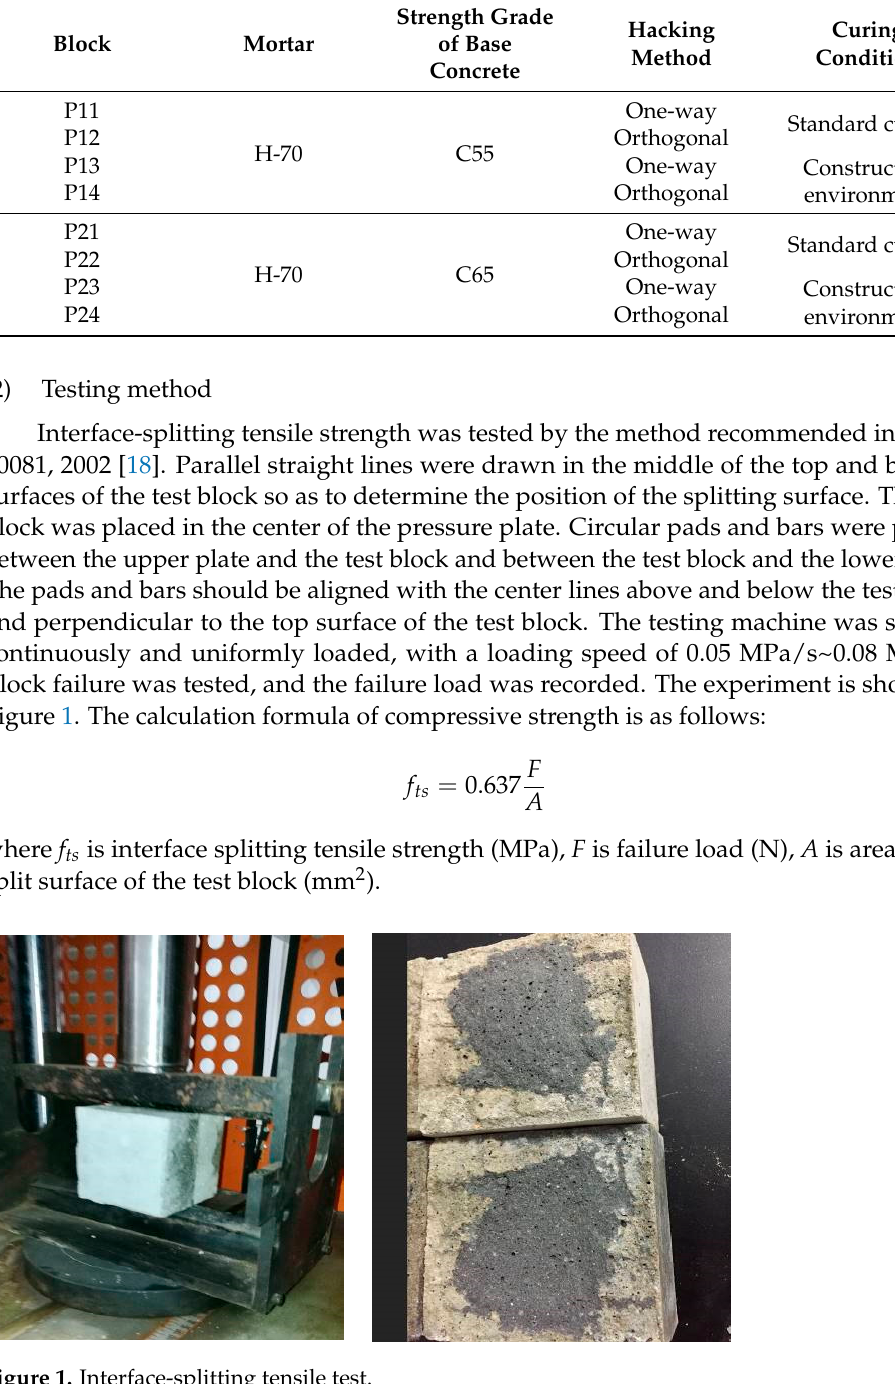
Table 1. The production scheme of test blocks for interface splitting tensile strength.